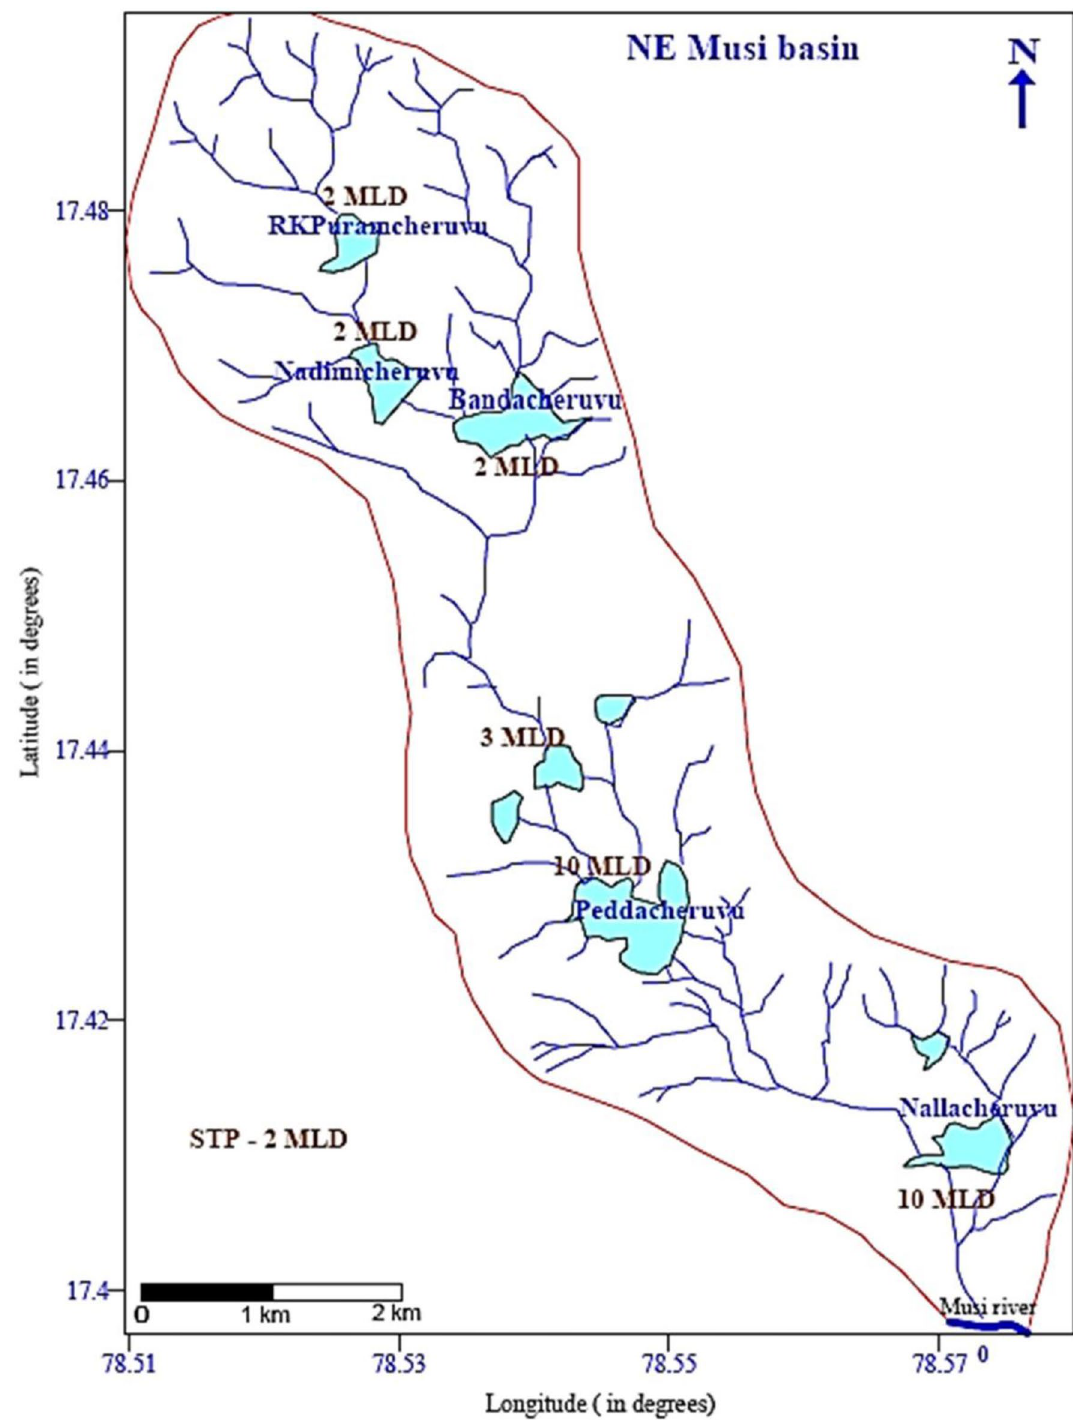
Fig. 15 Proposed capacity of STPs on